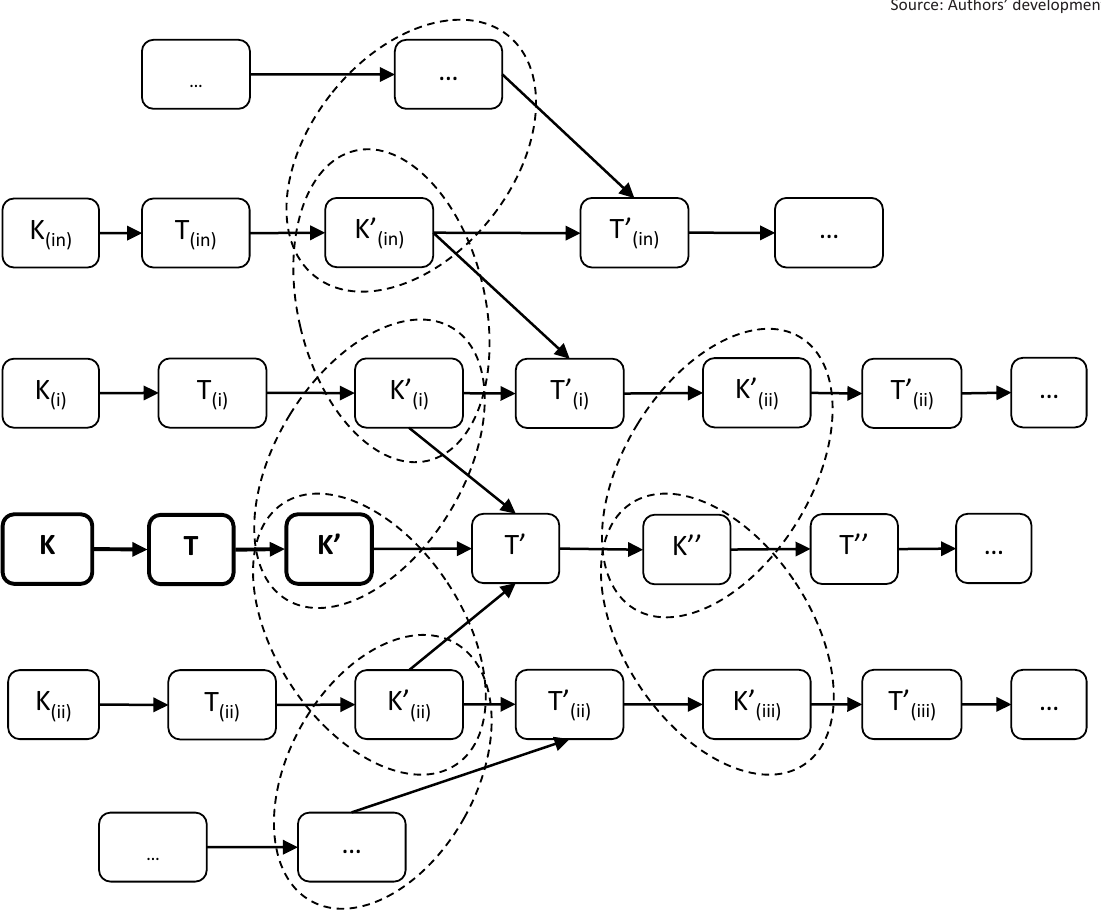
Figure 2. Schematic representation of knowledge transformation chains during the technology